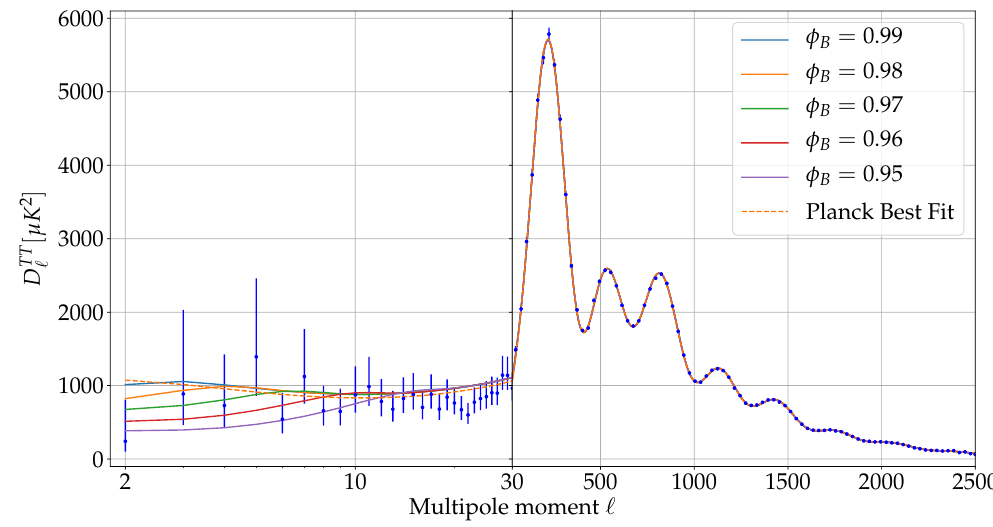
Figure 5. Angular power spectrum of temperature anisotropies for the Planck best fit and the NO-vacuum state at the bounce on background solutions obtained with different values of the inflaton at that bounce and m = 1.20 10 − 6 . ×